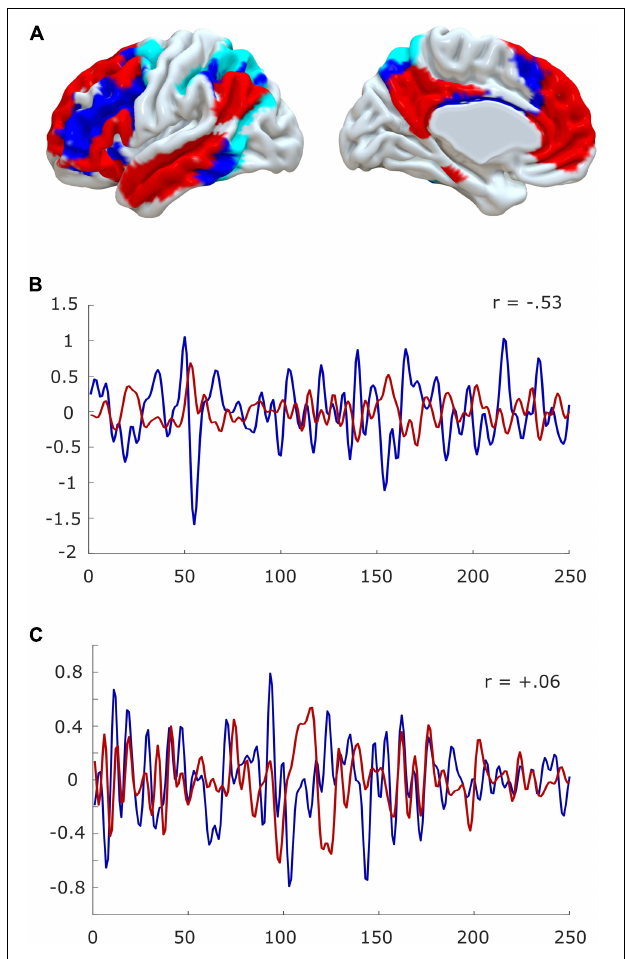
FIGURE 4 | Anticorrelations in the human brain. (A) Surface projection of the default mode network (red) and fronto-parietal (blue)/dorsal attention networks (cyan) onto medial and lateral surfaces of a standard brain (left hemisphere). (B) The timecourses of default mode and fronto-parietal networks are anti-correlated during quiet wakefulness. (C) Anticorrelations are reduced or even abolished in the anaesthetised brain. Data from one representative subject, before and during propofol anaesthesia; for experimental details, see Stamatakis et al. (2010) and Varley et al.